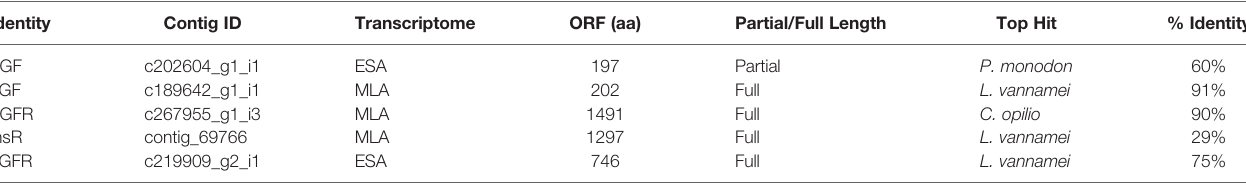
TABLE 3 | Tyrosine receptor kinases and ligands expressed in G. lateralis MLA or ESA Y-organ transcriptomes (16, 20, 21). Identity Contig